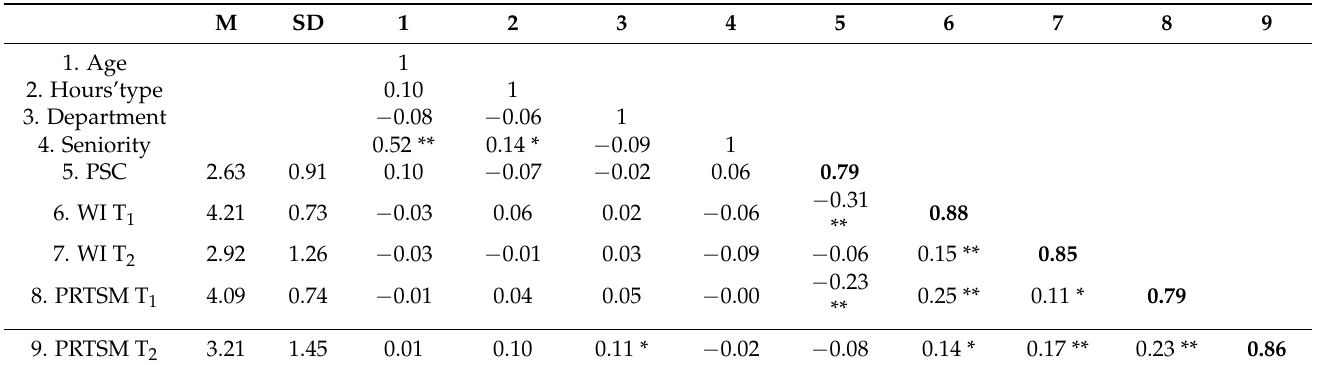
Table 1. Means, standard deviations and correlations among